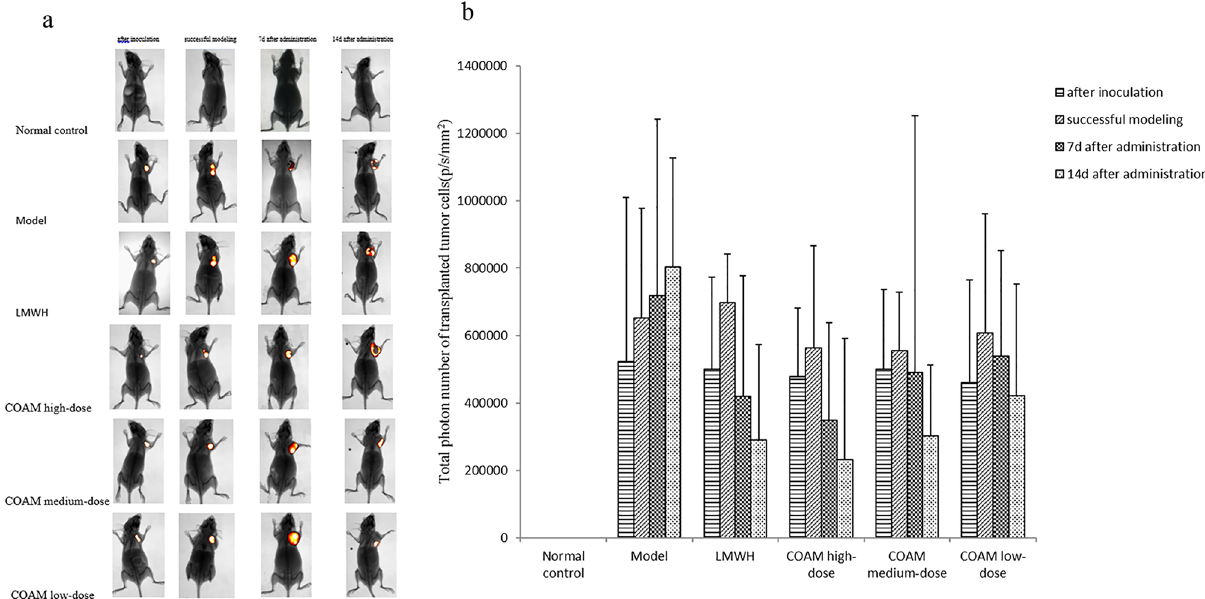
Figure 1. In vivo imaging results of transplanted breast cancer cells 4TI-Luc in mice. ( a – b ) Female BALB/c-nu mice were inoculated with luciferase-labeled mouse breast cancer cells 4T1-luc. Mice were mock-treated with saline, were treated with low-molecular-weight heparin, or various doses of Compound Opening Arrow Mixture (COAM) after successful modeling. The growth of transplanted tumor cells was observed using a small animal in vivo imaging system on the 1st day after successful modeling and on the 7th and 14th day after drug administration. ( a ) Representative in vivo images of mice on the 7th day after drug administration. ( b ) Summarized data on total photon number of transplanted tumor cells (p/s/mm2) in the indicated groups at specified time points. Normal control group, mice without inoculation of tumors and treatments; Model group, mice with inoculation of tumors and treatments with saline; LMWH group, mice with inoculation of tumors and treatments with 1500 U/Kg low-molecular-weight heparin once a day by gavage; COAM high-dose group, mice with inoculation of tumors and treatments with high-dose of COAM (6 g/ml) once daily by gavage; COAM medium-dose group, mice with inoculation of tumors and treatments with medium-dose of COAM (3 g/ml) once daily by gavage; COAM low-dose group, mice with inoculation of tumors and treatments with low-dose of COAM (1.5 g/ml) once daily by gavage. n = 5 for each